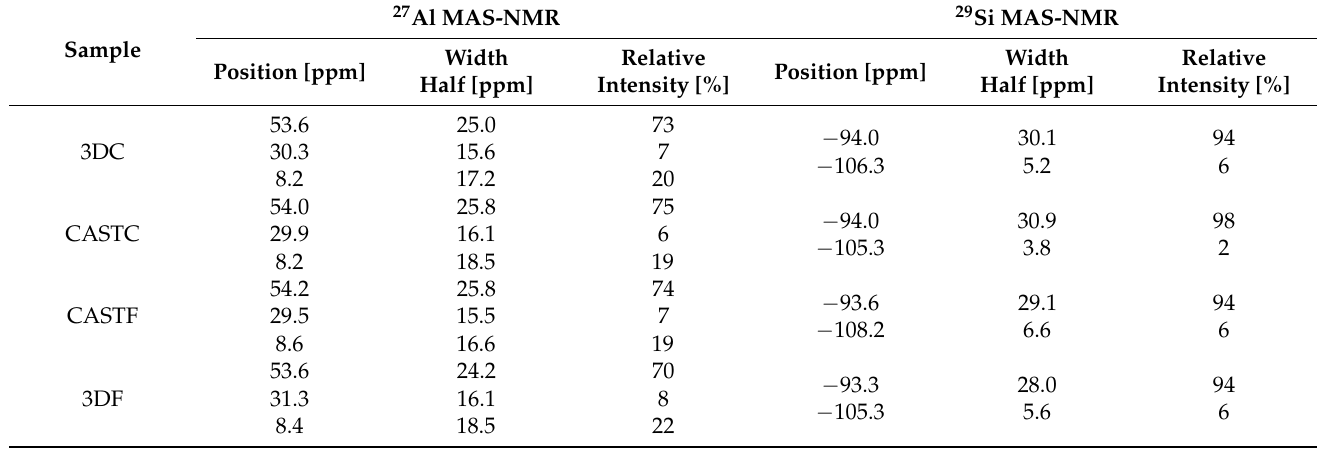
Table 5. Spectrum analysis 27 Al and 29 Si